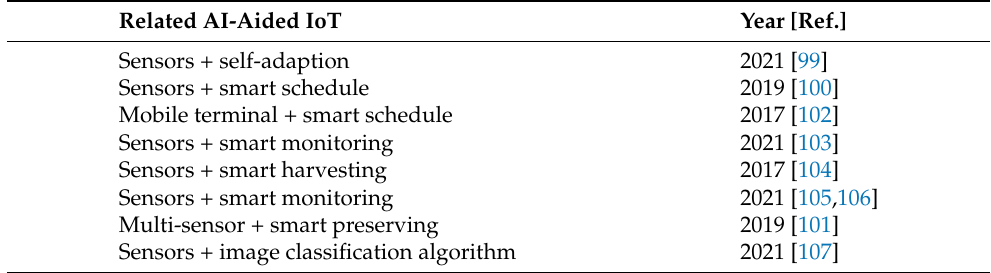
Table 3. Existing studies on AI-aided IoT applied in smart library sustainability.